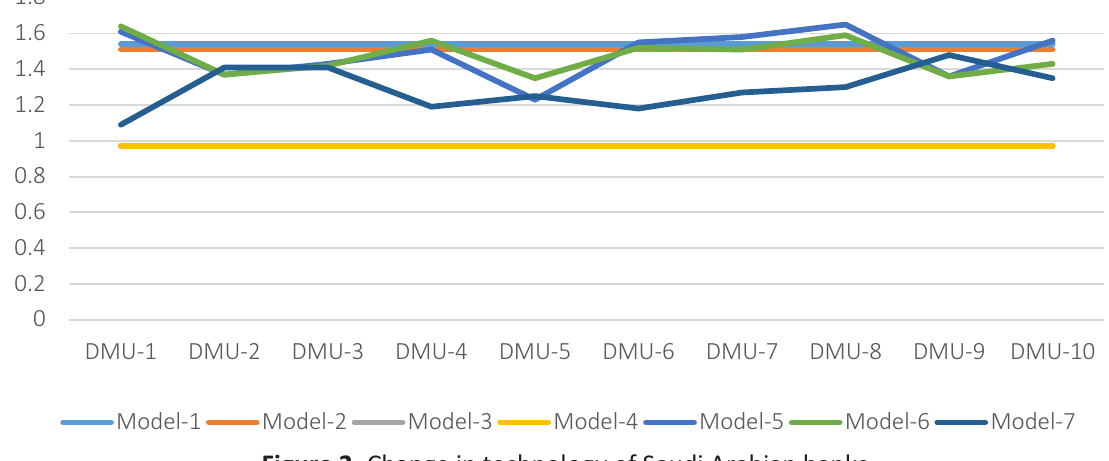
Figure 2. Change in technology of Saudi Arabian